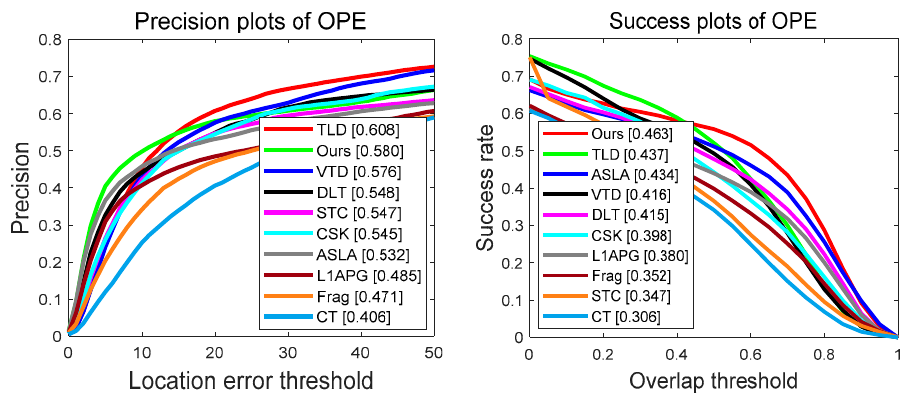
Figure 4. The precision and success plots of the tracking results on the OTB-2013 benchmark dataset. The legends contain the scores of the center location error with the threshold of 20 pixels and values of the area under curve for all trackers in the precision and success plots, respectively. Note that the color of one curve is determined by the rank of the corresponding trackers, not their names.